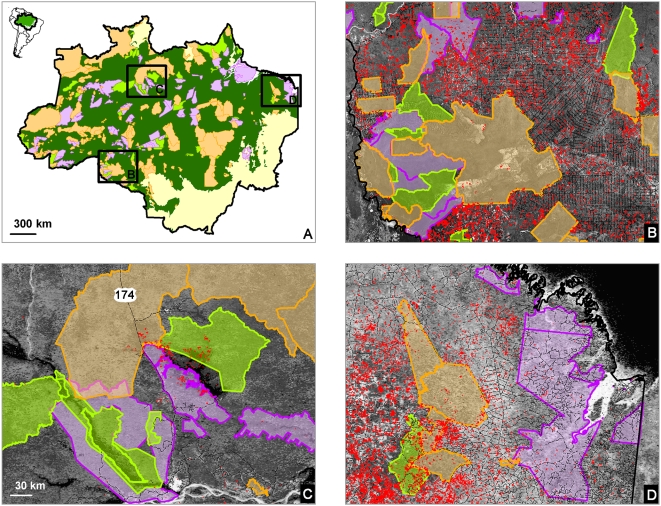
Regional differences in reserve protection against fire.A) Spatial distribution of reserves in the Brazilian Amazon. Close ups of areas in black squares where all reserve types are in close proximity, left to right: B) Rondônia, C) the BR-174 north of Manaus, and D) eastern Amazon (Maranhão and Pará). The WFA hot pixels for 1996–2006 are shown as red dots. Line colors denote reserve types: orange, indigenous lands; purple, limited use areas; green, fully protected parks. The background images are Landsat MrSID images (https://zulu.ssc.nasa.gov/mrsid/), and MODIS Blue Marble images, from the year 2000.